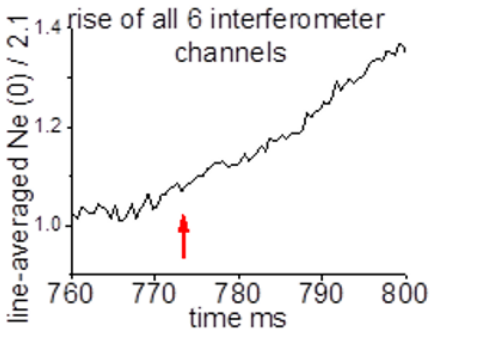
Fig.5. Timetraces of Ne (0) / 2.1 line-averaged in shot 68348, the start of Ne rise is shown by